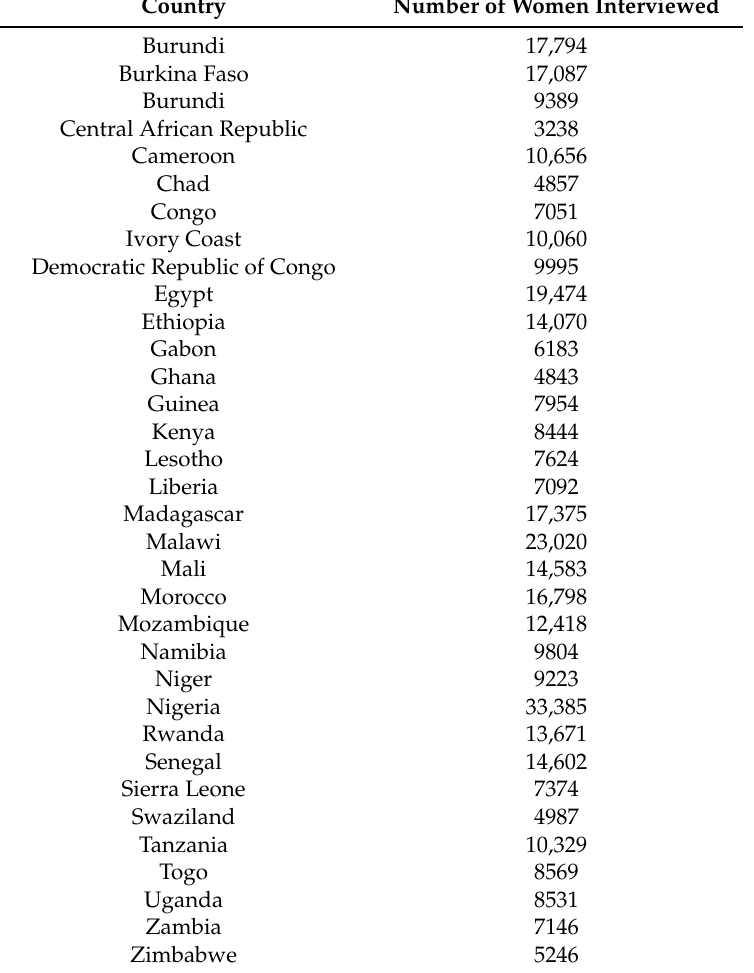
Table 1. Survey characteristics of the